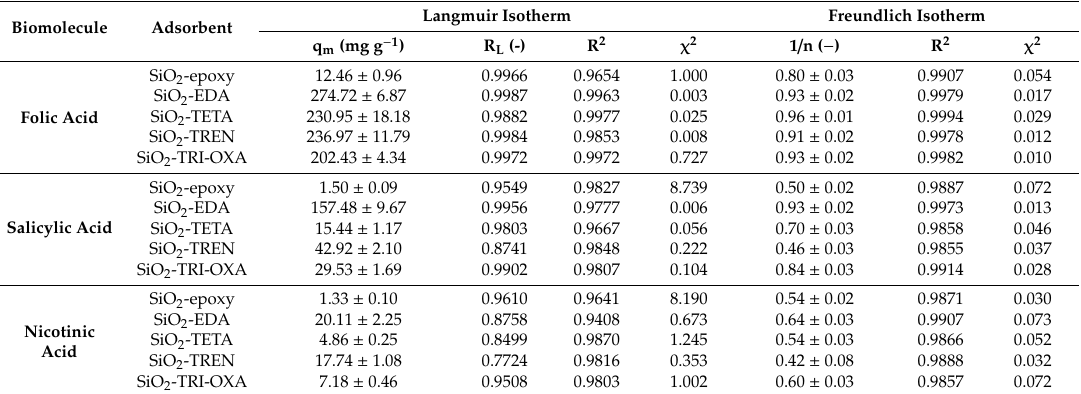
Table 1. Isothermal parameters of the drugs’ adsorption on the PAMAM-modified materials. Langmuir Biomolecule Adsorbent